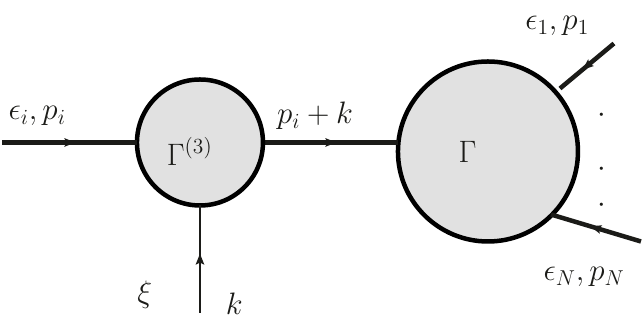
Figure 5 . Diagram having soft particle attached to external (cid:12)nite energy leg via 1PI three point vertex which starts contributing at leading order in soft